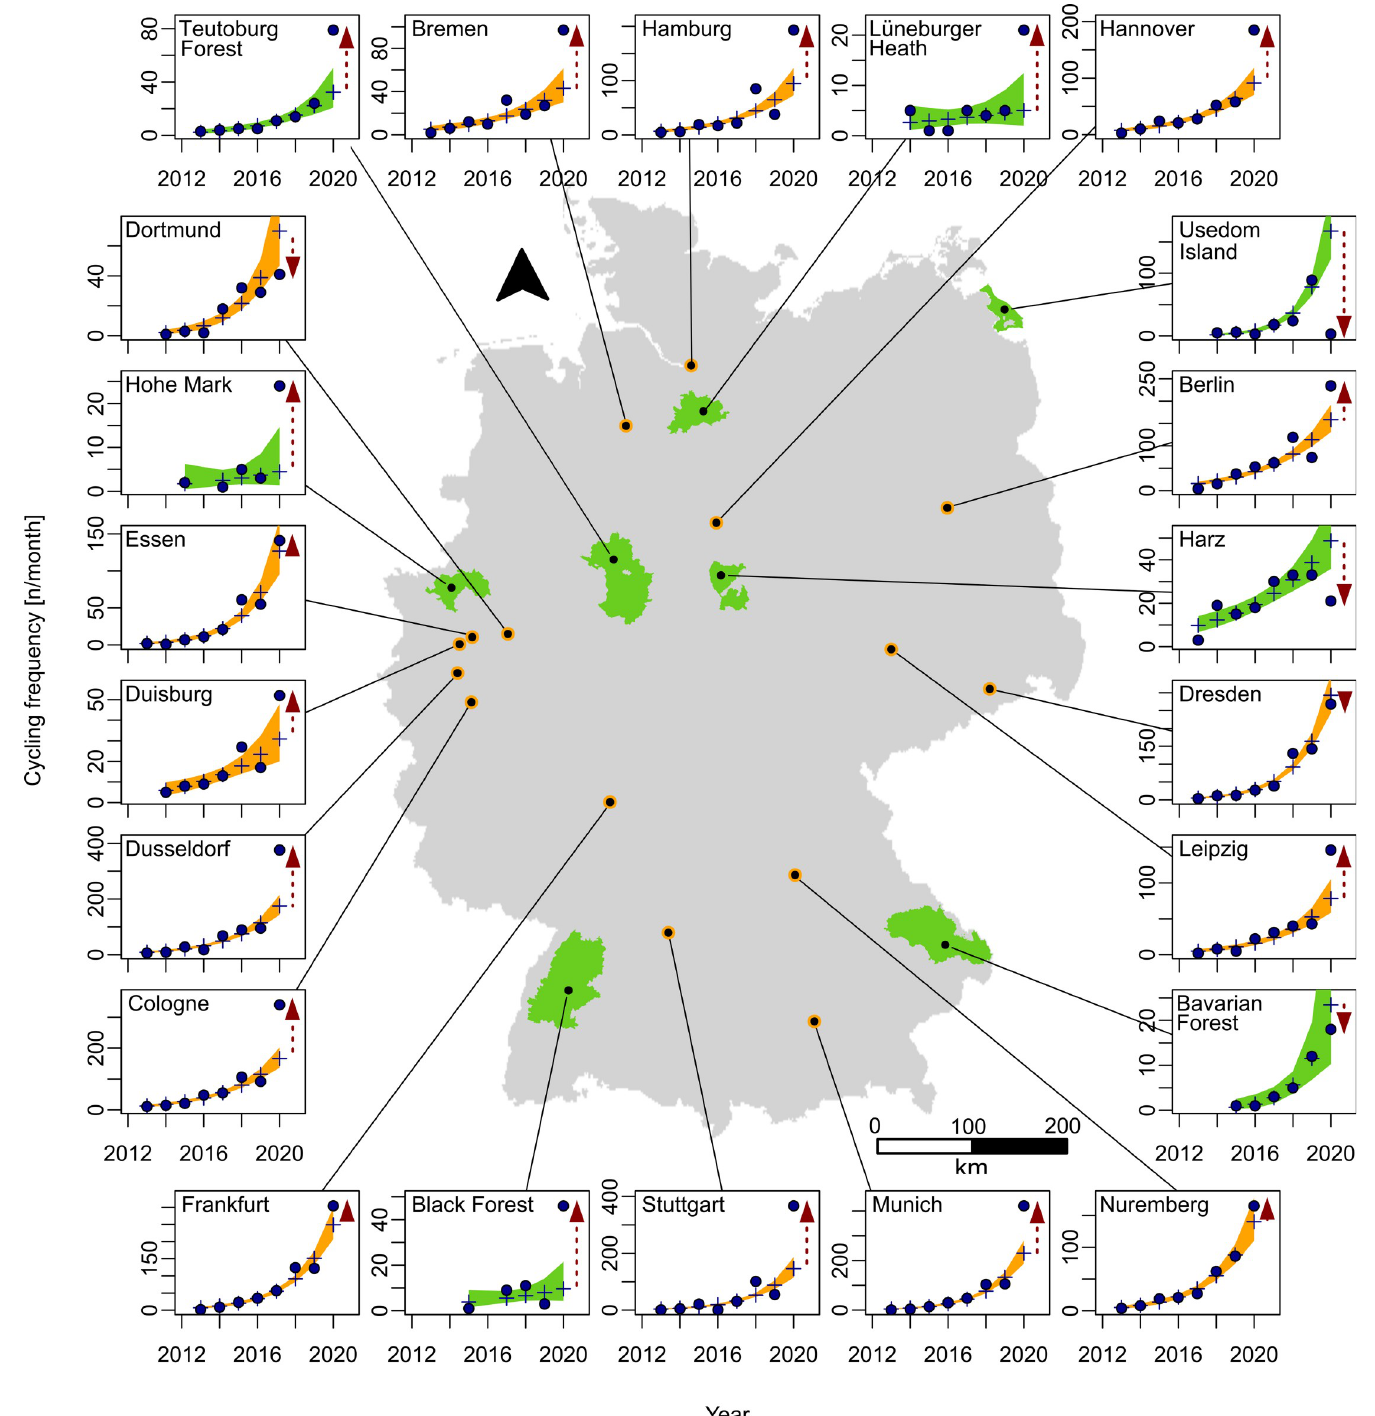
Fig 1. Map of study sites and respective cycling frequency. Cycling frequency displayed as measured (point) and predicted (plus, Modell A with user numbers as factor) values for the month April for all urban (orange) and rural (green) sample sites. The red dashed arrows indicates a Covid-19 related difference and the direction of change in user frequency. The background shows the outlines of Germany with the locations of focal cities and nature parks [54].